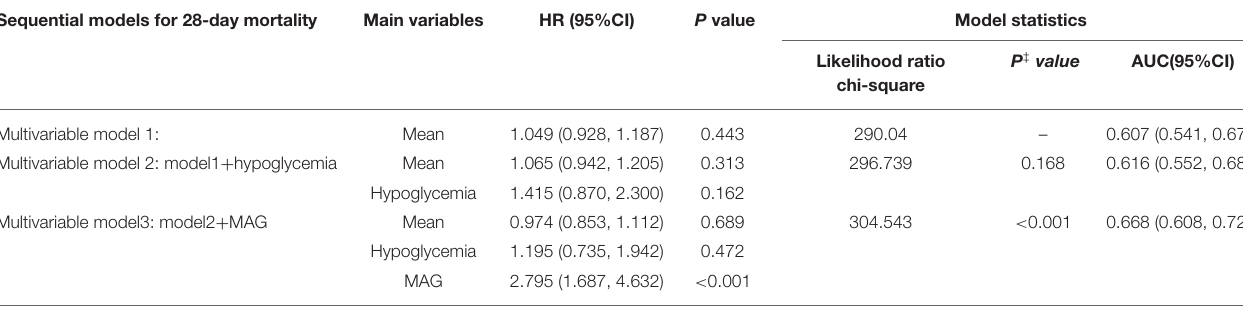
TABLE 4 | Multivariable COX regression: associations of hypoglycemia and MAG With 28-day mortality. Sequential models for 28-day